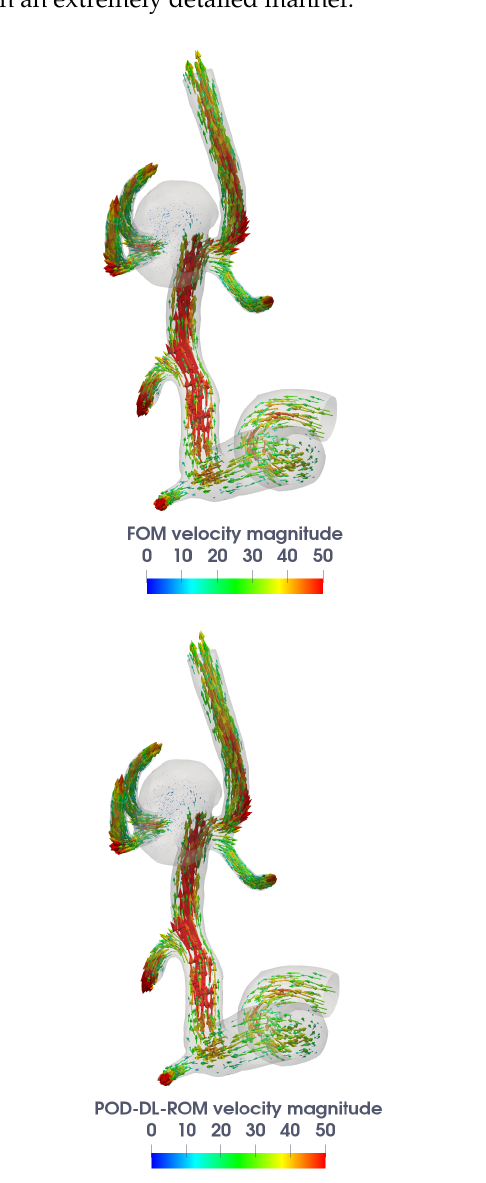
Figure 13. Test case 3: FOM ( top ) and POD-DL-ROM ( bottom ) velocity fields for the testing-parameter = ( 5.9102,3.1179 ) at the systolic peak t = 0.18 instance µ test